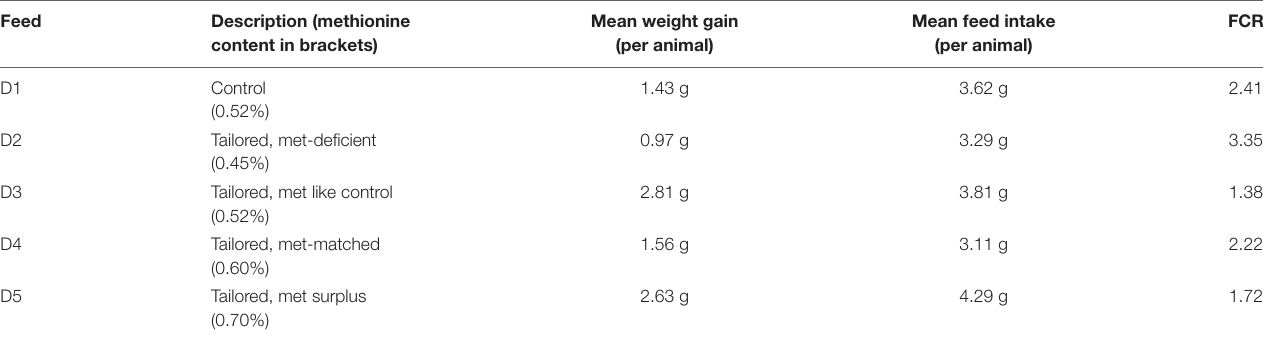
Mean feed intake (per animal)